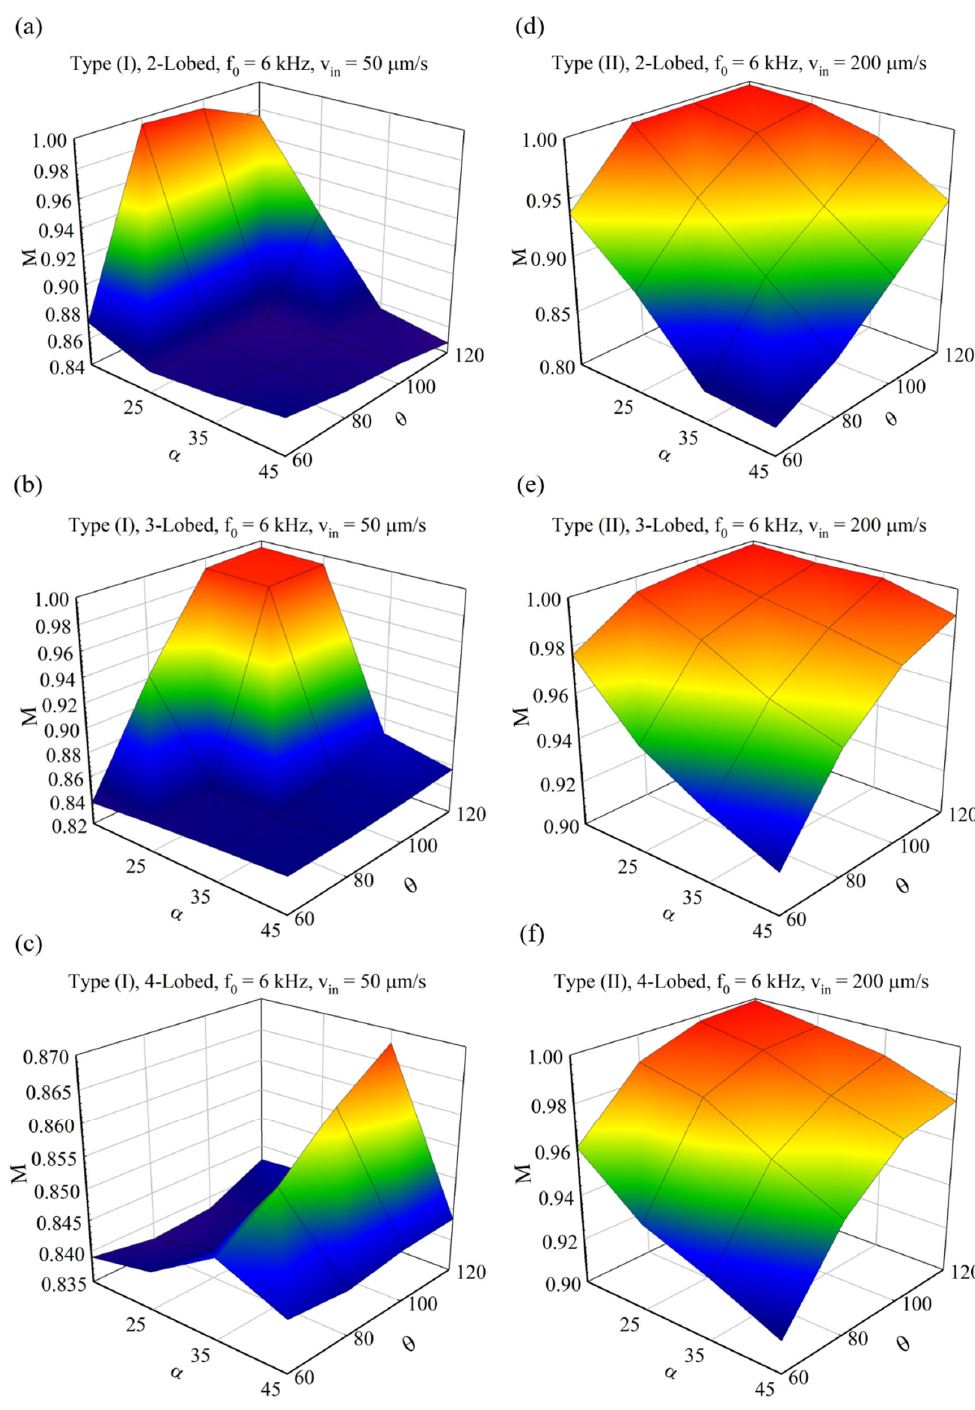
Figure 4. MI parameter with respect to angles 𝛼 and 𝜃 of obstacles: ( a,b,c ) Type (I) for 2, 3, and 4 ‐ lobed structure. ( d,e,f ) Type (II) for 2, 3, and 4 ‐ lobed structure. Accordingly, based on the results obtained in Figures 3 and 4, we acquired the best value for angles 𝛼 and 𝜃 for further investigations. For this, the optimal angles used in the continuation of the modeling are listed in Table 3.